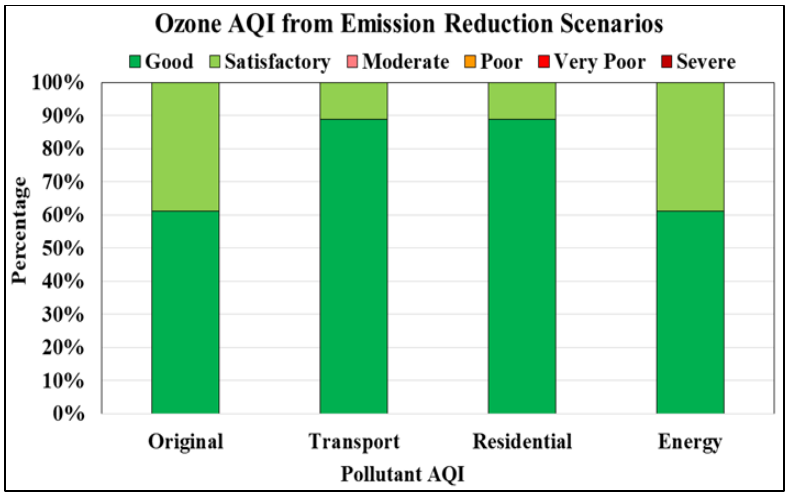
Figure 9. Air quality index of ozone for original and proposed emission scenarios.